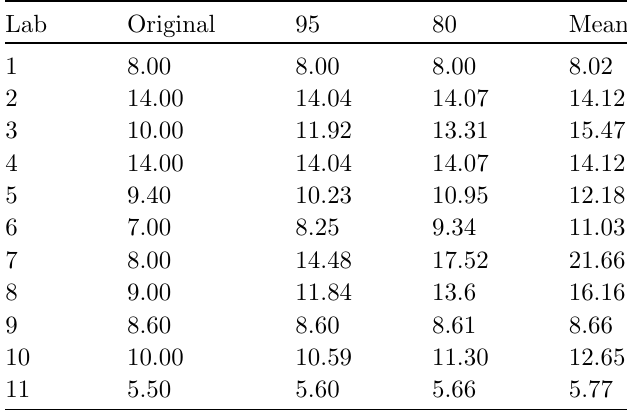
Table 1. Uncertainties adjusted to various levels using the relative entropy method.